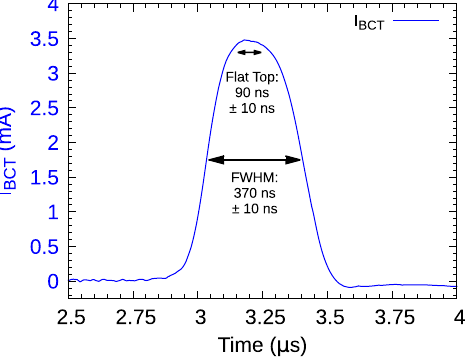
FIG. 12. Measured 14 keV He þ beam pulse with 3.5 mA amplitude. The baseline of the BCT signal was manually restored.